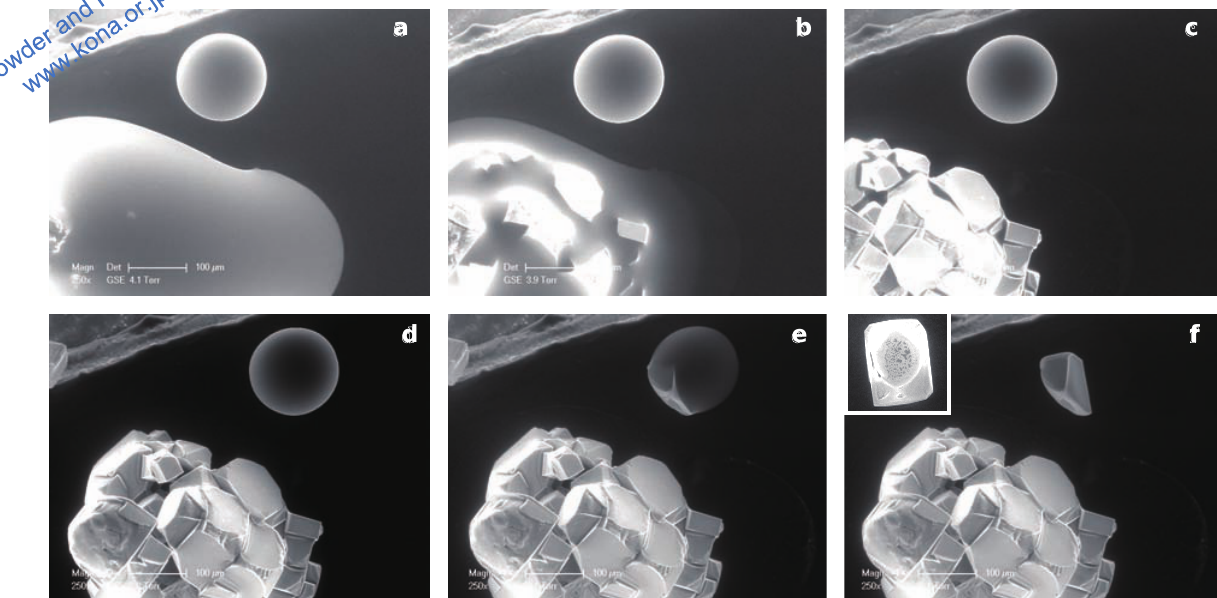
Fig. 8 Time sequence of ESEM images of the recrystallization of NaCl at RH ＜ DRH (a to f); size bar is 100 µ m in all images.